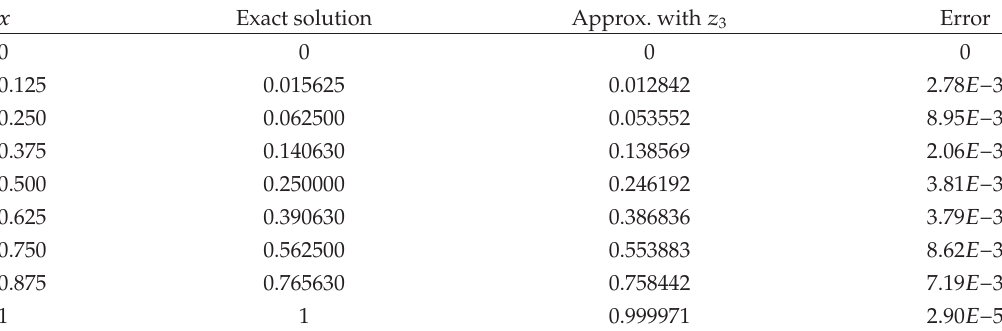
Table 3: Numerical results of Example 4.3.